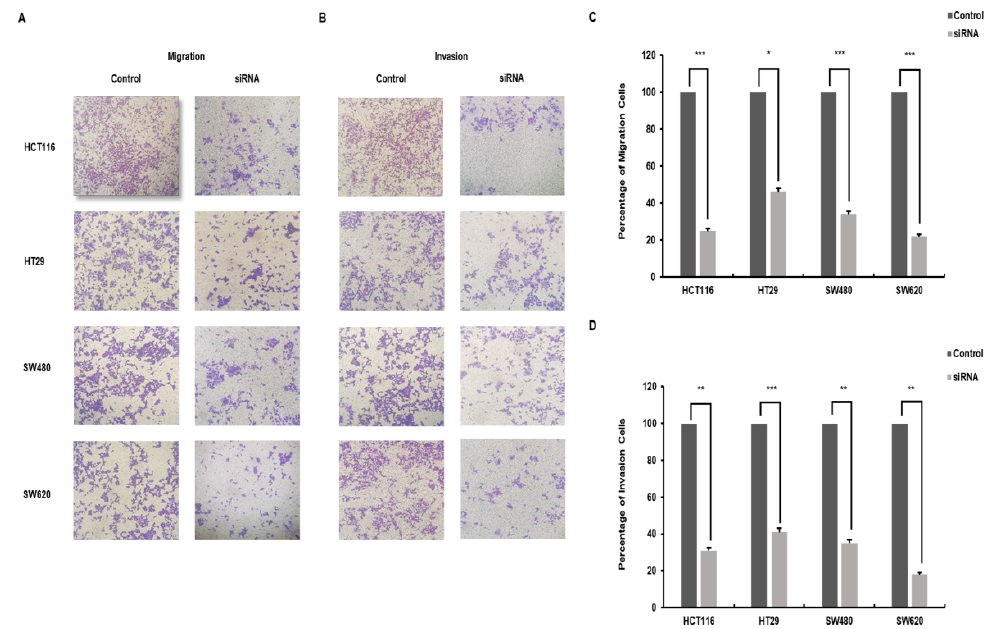
Figure 3. The results of the transwell assay regarding metastasis. Reduced expression of SMOX inhibits the migration and invasion abilities of CRC cells. The result of the chamber migration assay and invasion assay. Cells were visualized in violet color. ( A ) Migration of the siRNA treatment group was reduced in comparison with the control group. The images of the cells were on the bottom membrane (Original magnification × 40). ( B ) siRNA-treated cells were less numerous than control cells. The images of the cells were on the bottom membrane (Original magnification × 40). ( C ) The graph indicates the percentage of cells and the results of the chamber migration assay (HCT116, 35%; HT29, 46%; SW480, 34%; and SW620, 22%) (* p < 0.05, *** p < 0.001). ( D ) The graph expresses the percentage of cells in the chamber invasion assay (HCT116, 31%; HT29, 41%; SW480, 35%; and SW620, 18%) (** p < 0.01, *** p < 0.001).